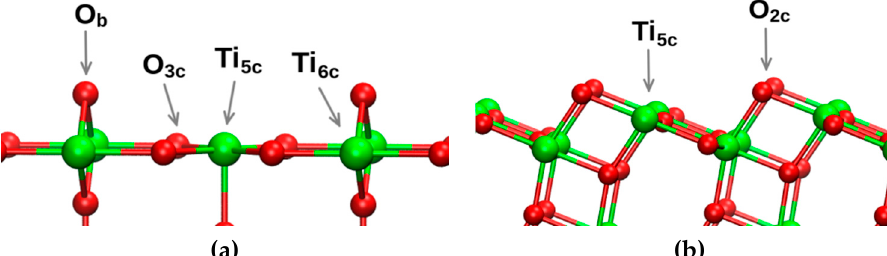
Figure 1. Structure of surfaces; laboratory z -direction is vertical. O b stands for bridging oxygen, O 3c a three-coordinated surface oxygen, Ti 5c a penta-coordinated surface Ti atom, and Ti 6c denotes a hexa-coordinated Ti atom. ( a ) rutile-110, and ( b ) anatase-101.